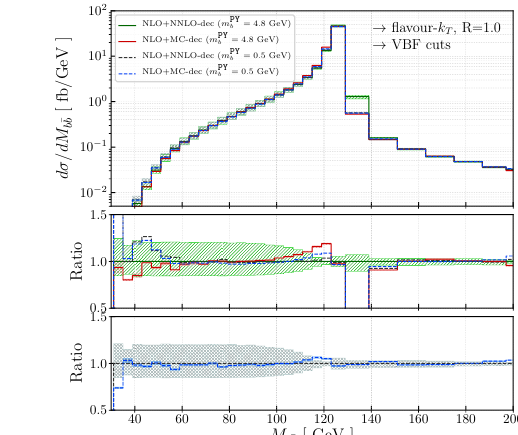
blue dashes for m PY